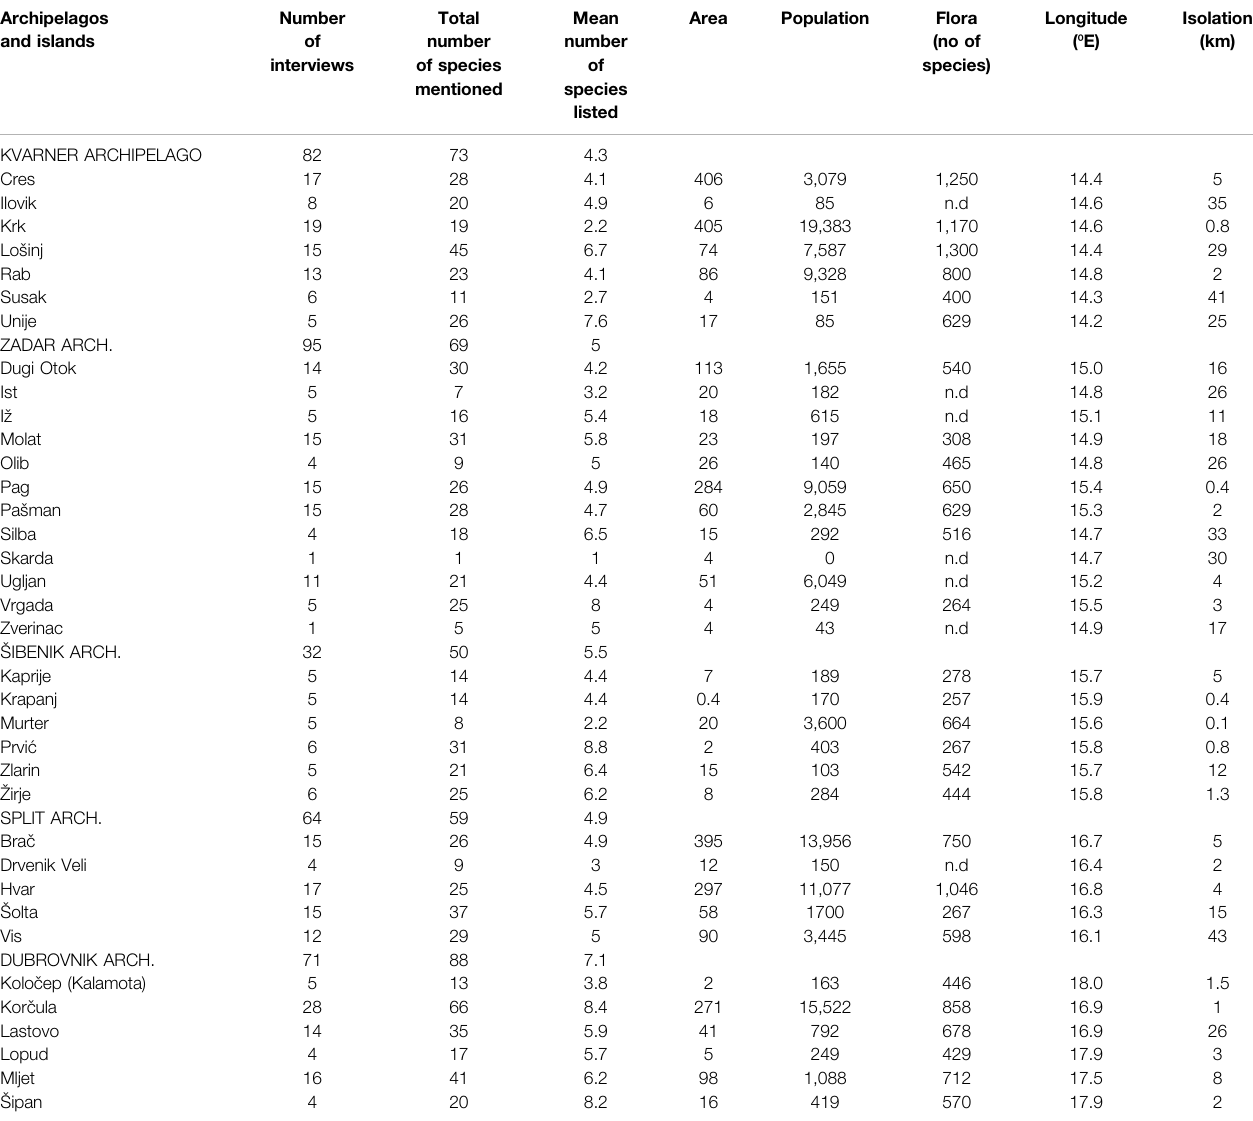
TABLE 1 | List of the studied islands. Archipelagos and islands